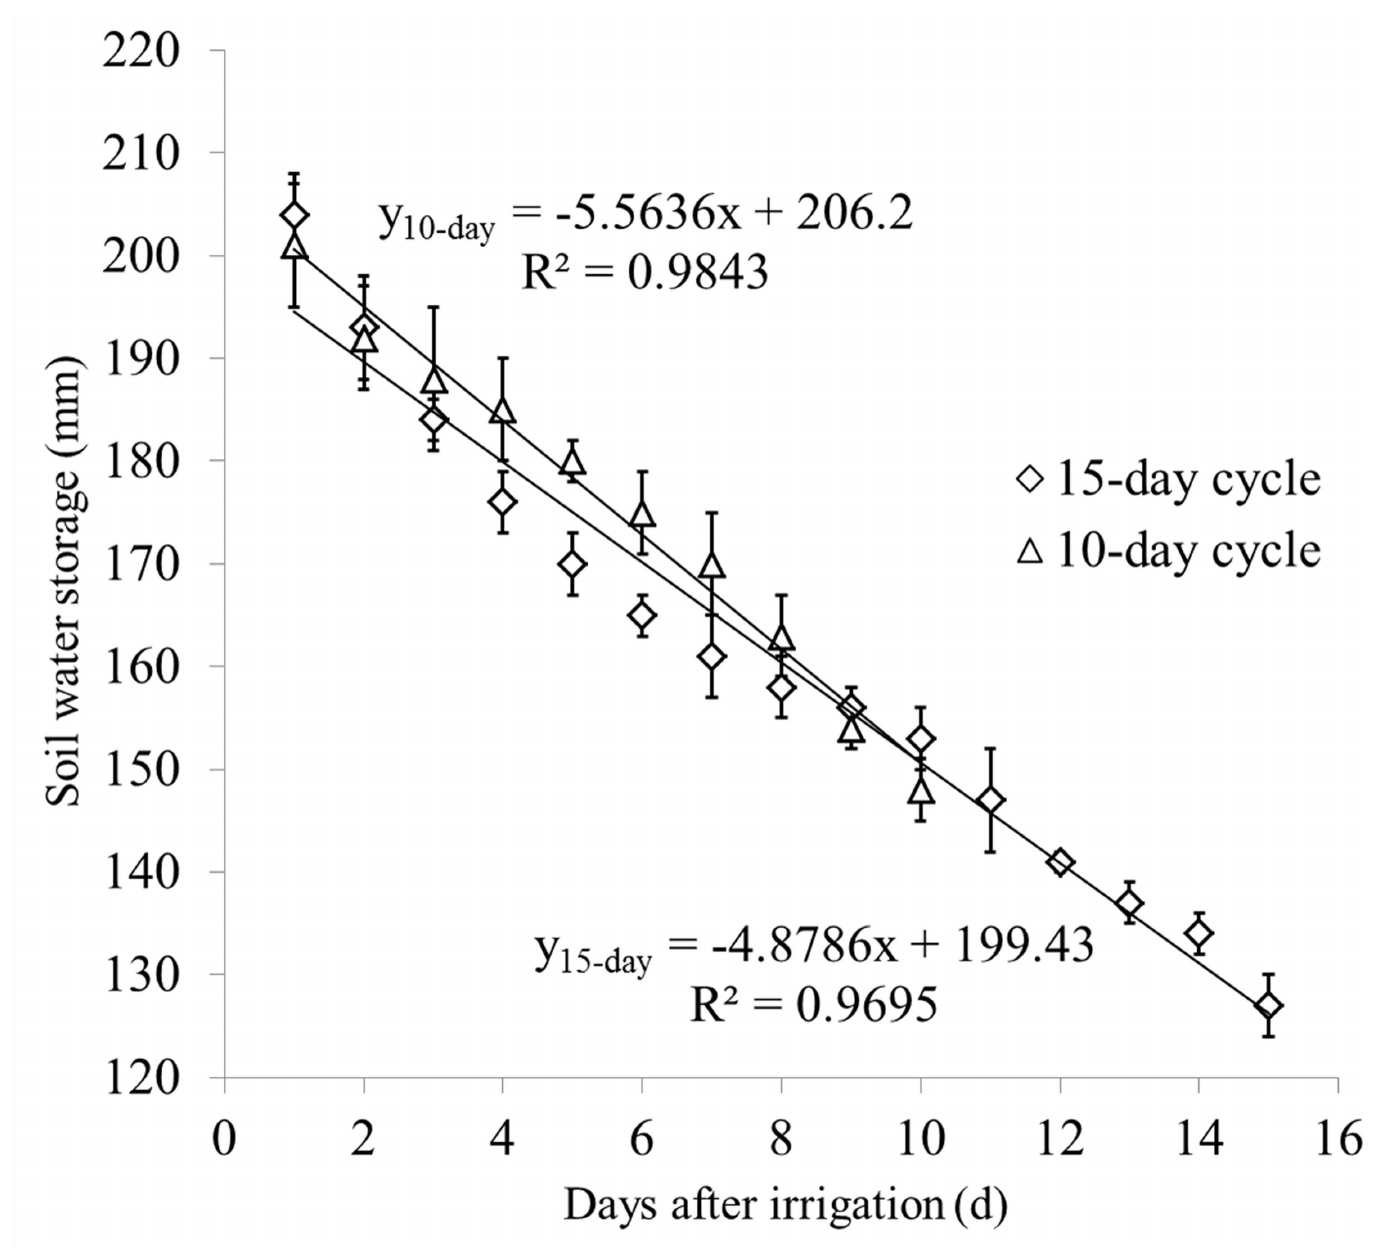
Fig 5. Dynamics of soil water storage to a depth of 2 m within an irrigation cycle. a: 15-day-cycle for Tamarix ramosissima and Haloxylon ammodendron ; b: 10-day-cyclefor Calligonumarborescens .